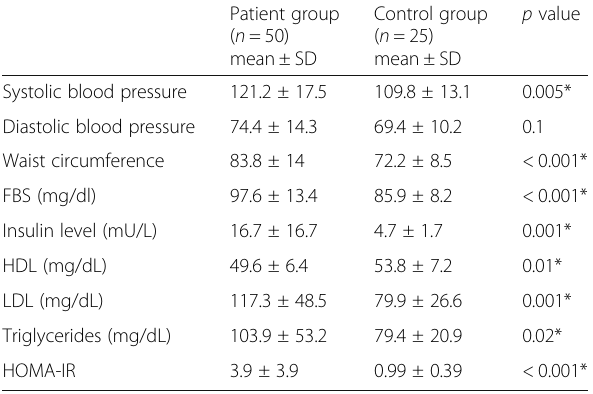
Table 3 MetS components and insulin resistance in both groups